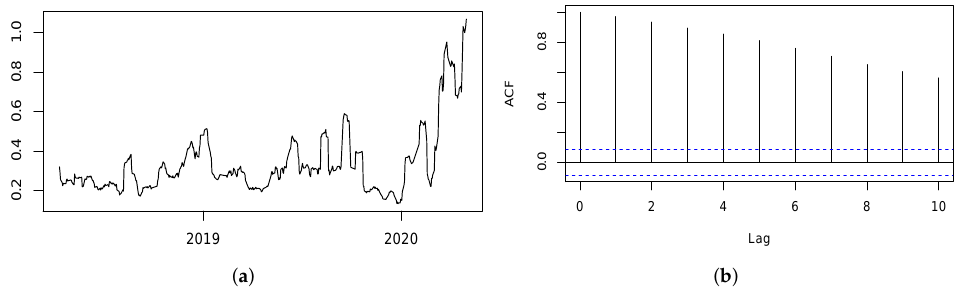
Figure 1. Volatility of INE and associated ACFs. ( a ) Volatility. ( b ) ACFs. Note: this figure presents the estimated volatility of the INE returns from the period 2018–2020 via the Yang and Zhang [4] method. The associated ACFs of the volatility are also